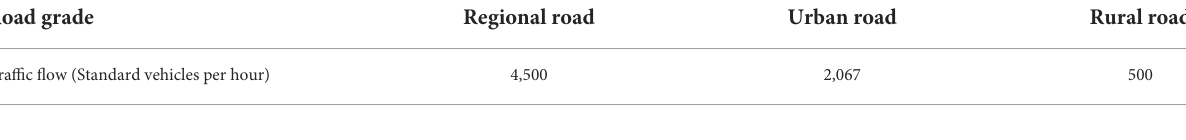
TABLE 3 Carbon absorption coefficient of land use (tCO 2 /hm 2